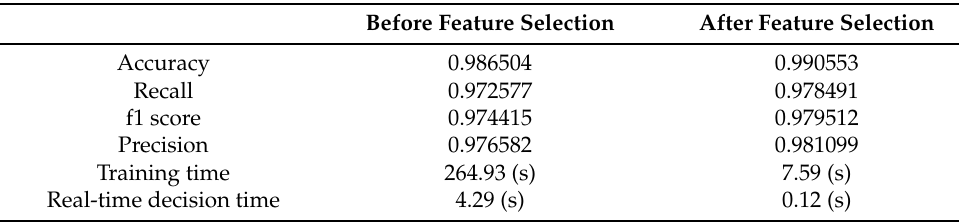
Table 6. Comparison before and after feature selection based on Linear_SVM.